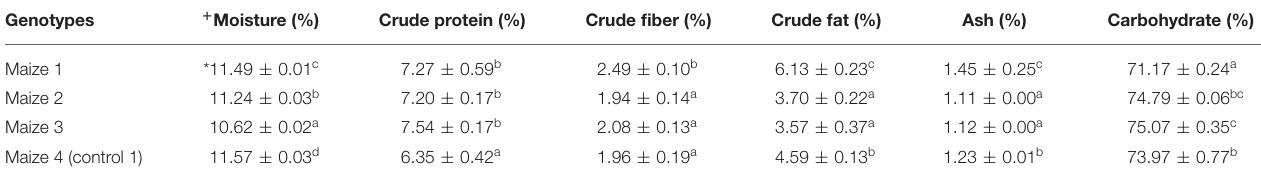
TABLE 1 | Chemical composition of maize flour from provitamin A maize genotypes and yellow maize. Genotypes